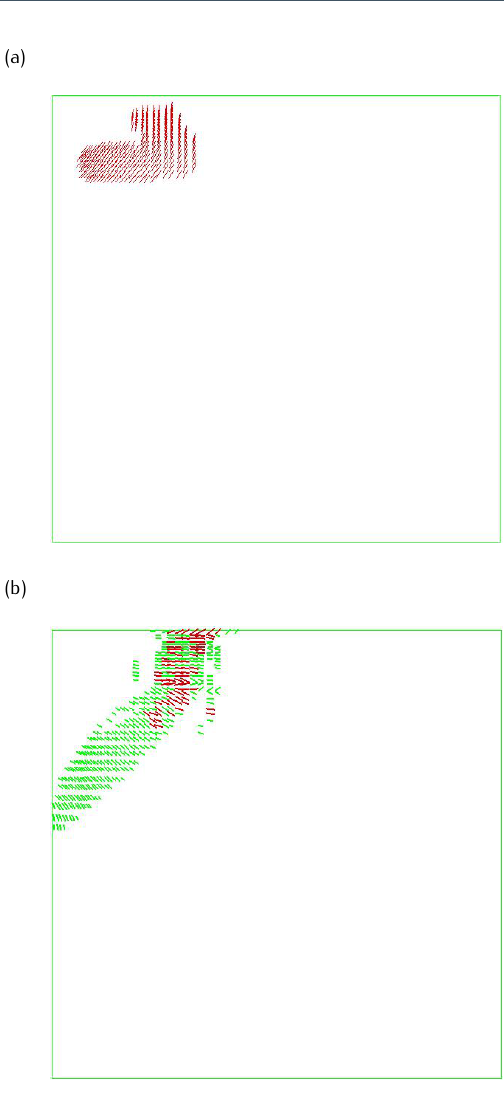
Figure 17. Edge load, (a) Vertical deformations [mm] at 100 kN, (b) Load-displacement curve.